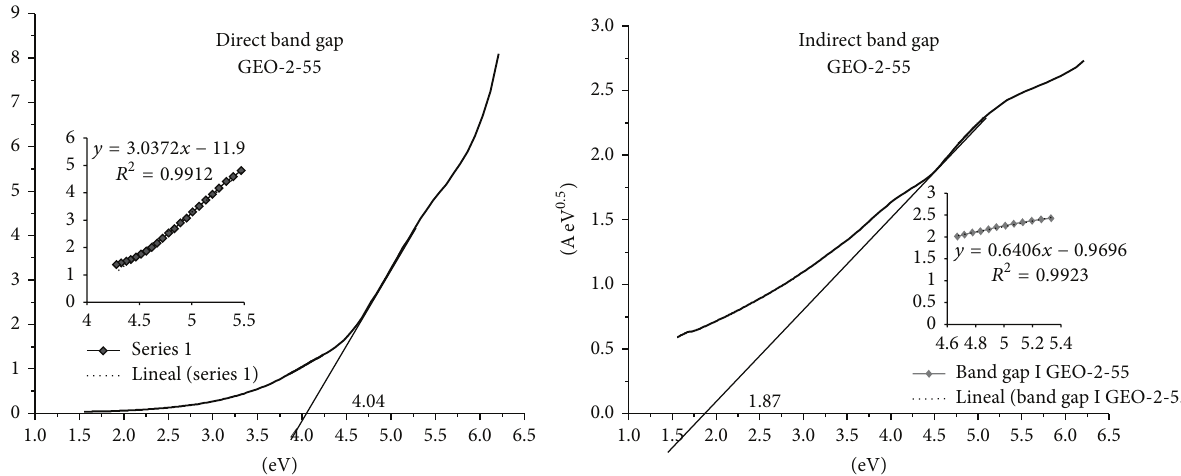
Figure 5: Determination of direct and indirect band gap from Tauc’s plot of ( 𝛼ℎ ] ) 2 versus photon energy ( ℎ ] ), for GEO-2-55.